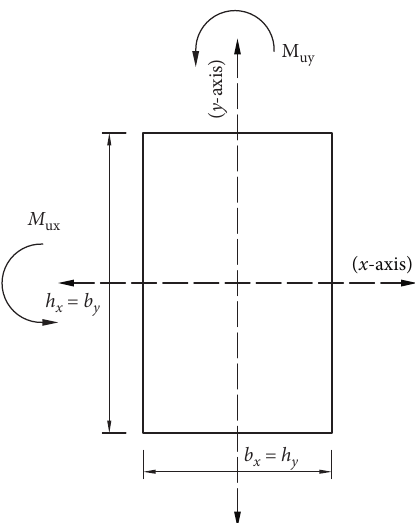
Figure 8: Biaxial column cross section.